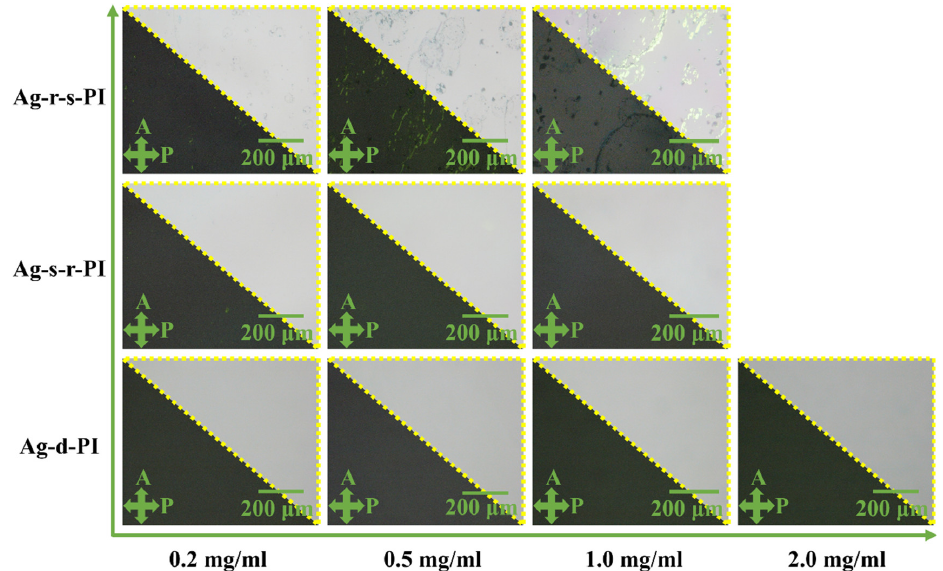
Figure 4. POM images of LC sandwiched between Ag-s-rPI thin layers, Ag-s-PI thin layers and Ag-d-PI thin layers, respectively.